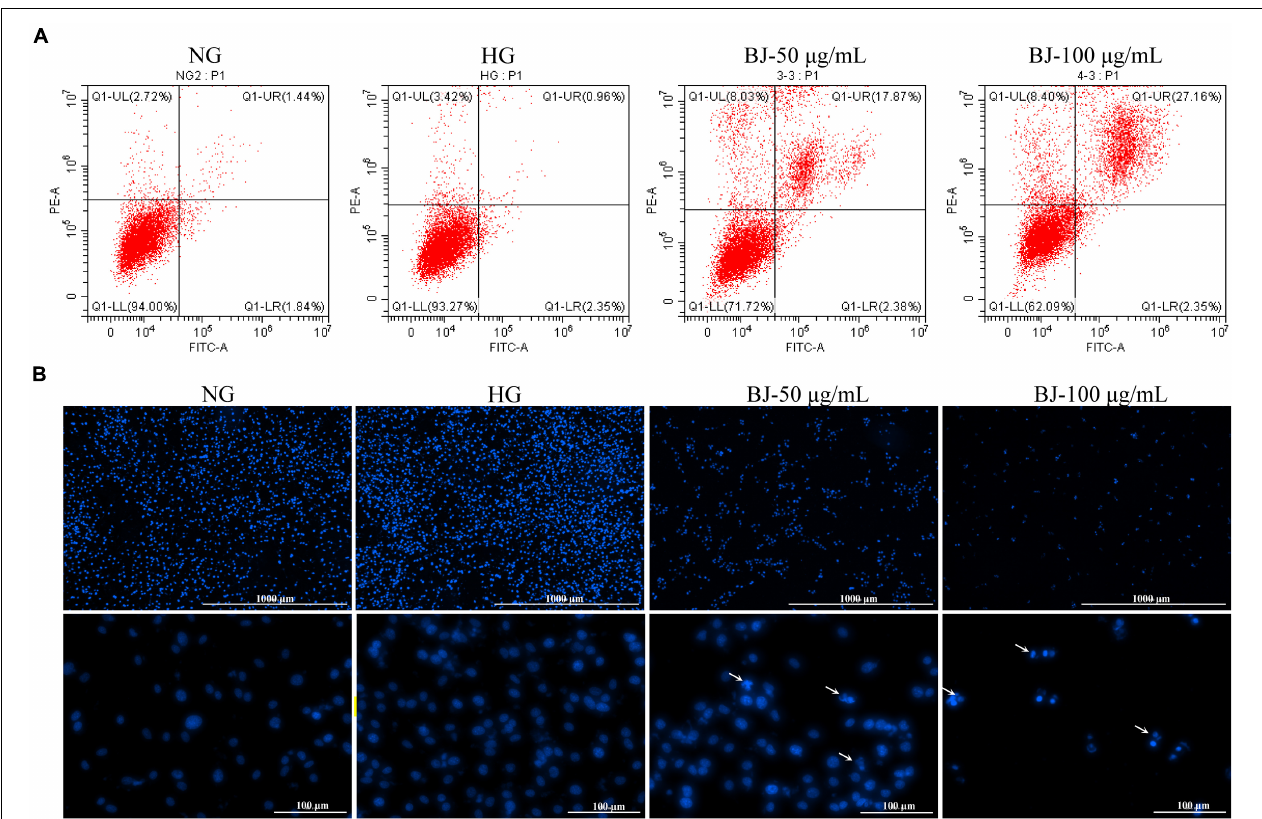
FIGURE 5 | Bie-Jia-Ruan-Mai-Tang (BJ) induces apoptosis of HRCECs exposed to high glucose. (A) The apoptosis rate was measured by the flow cytometry after AnnexinV-FITC/PI staining. (B) Nuclear morphology was detected by cell nuclear staining, and BJ enhanced the nuclear condensation and fragmentation. The arrows indicate nuclear condensation and